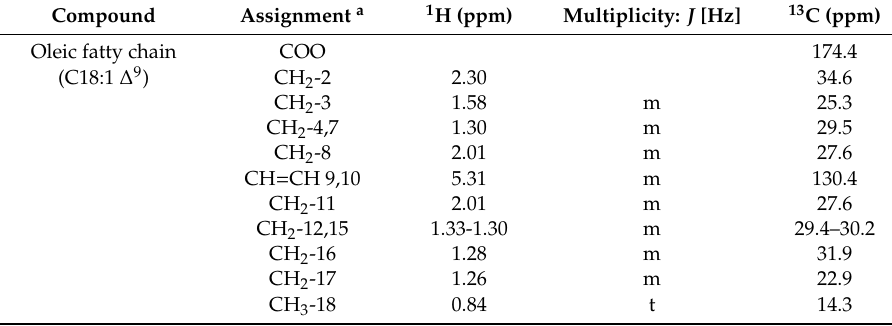
Figure 3. 1 H NMR spectrum of organic extract from tomato fruits of “Fiaschetta di Fondi” in CDCl 3 /CD 3 OD 2:1 v / v mixture. Signals used for the quantitative analysis have been labelled: I β -SIT , CH 3 , β -sitosterol; I STIG , CH 3 , stigmasterol; I FA , α -CH 2 , all fatty acids; I DI , diallylic CH 2 , linoleic acid; I TRI , diallylic CH 2 , linolenic acid; I UNS , CH=CH of all unsaturated fatty acids. Table 3. Metabolites identified and quantified in the 600.13 MHz 1 H spectra (27 °C) of organic extracts from Bamano, DuceMiel, King Creole, Sugarland, and Fiaschetta tomato cultivars.